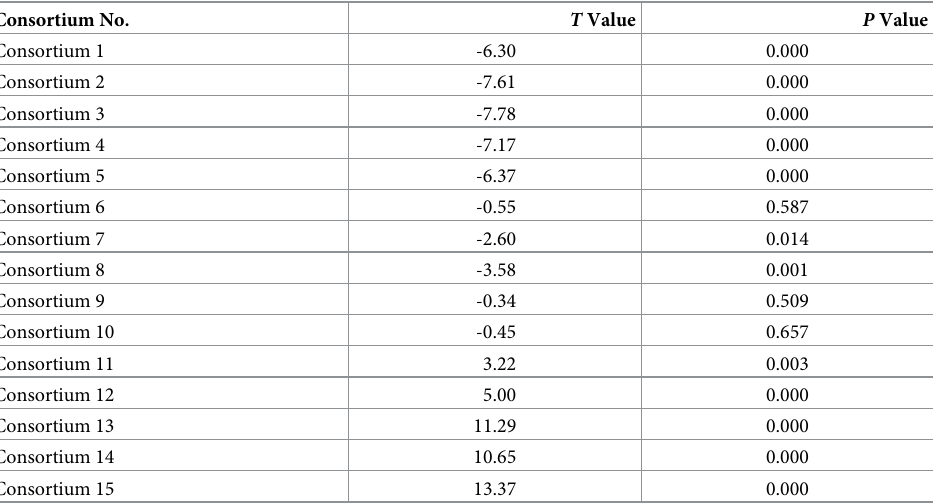
Table 4. ANOVA of fungal consortium producing cellulase.